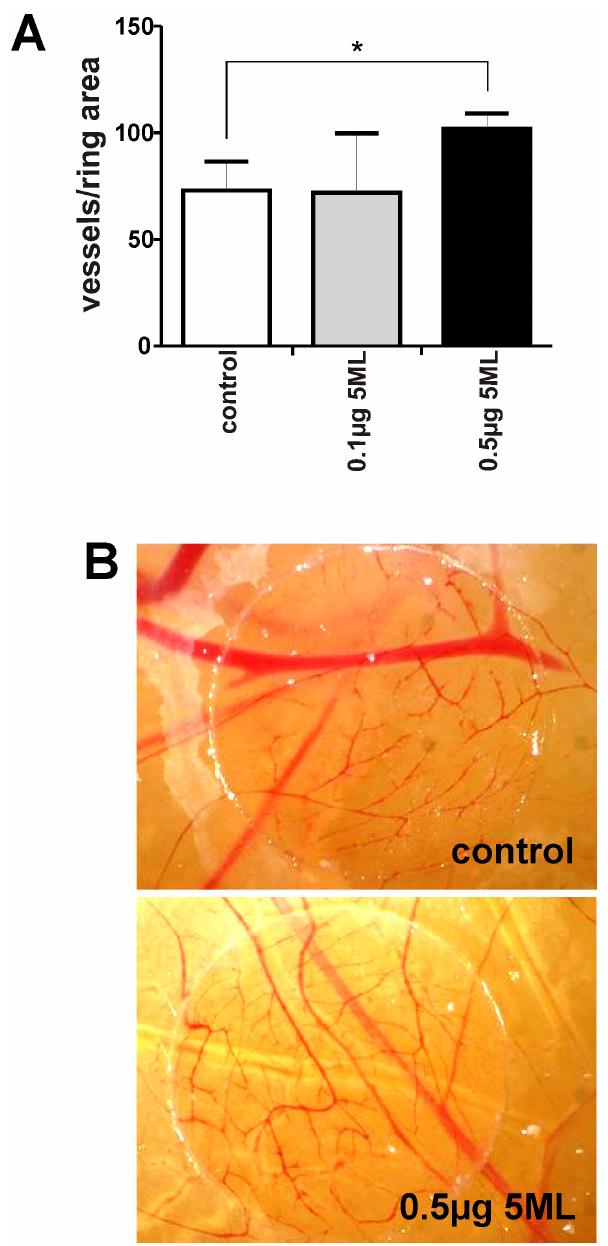
Figure 2. Effects of 5ML on blood vessel formation in the chicken chorioallantoic membrane assay (CAM) assay. Figure 2A: CAMs of 3-days- old chickens were incubated for 96 hours with the control solution (DMSO as the solvent control) or 0.1 or 0.5 m g 5ML. Figure 2A shows that the treatment with 5ML enhanced the formation of new blood vessels. 5ML significantly increased blood vessel formation at a concentration of 0.5 m g/egg. Figure 2B shows representative images of the CAM-assay (Magnification: 12,5 6 ). Blood vessels were counted in the ring area of the CAM to quantify effects of 5ML in vivo . All experiments were performed in triplicates. Asterisks indicate significant differences (* p , 0.05) compared to the corre- sponding